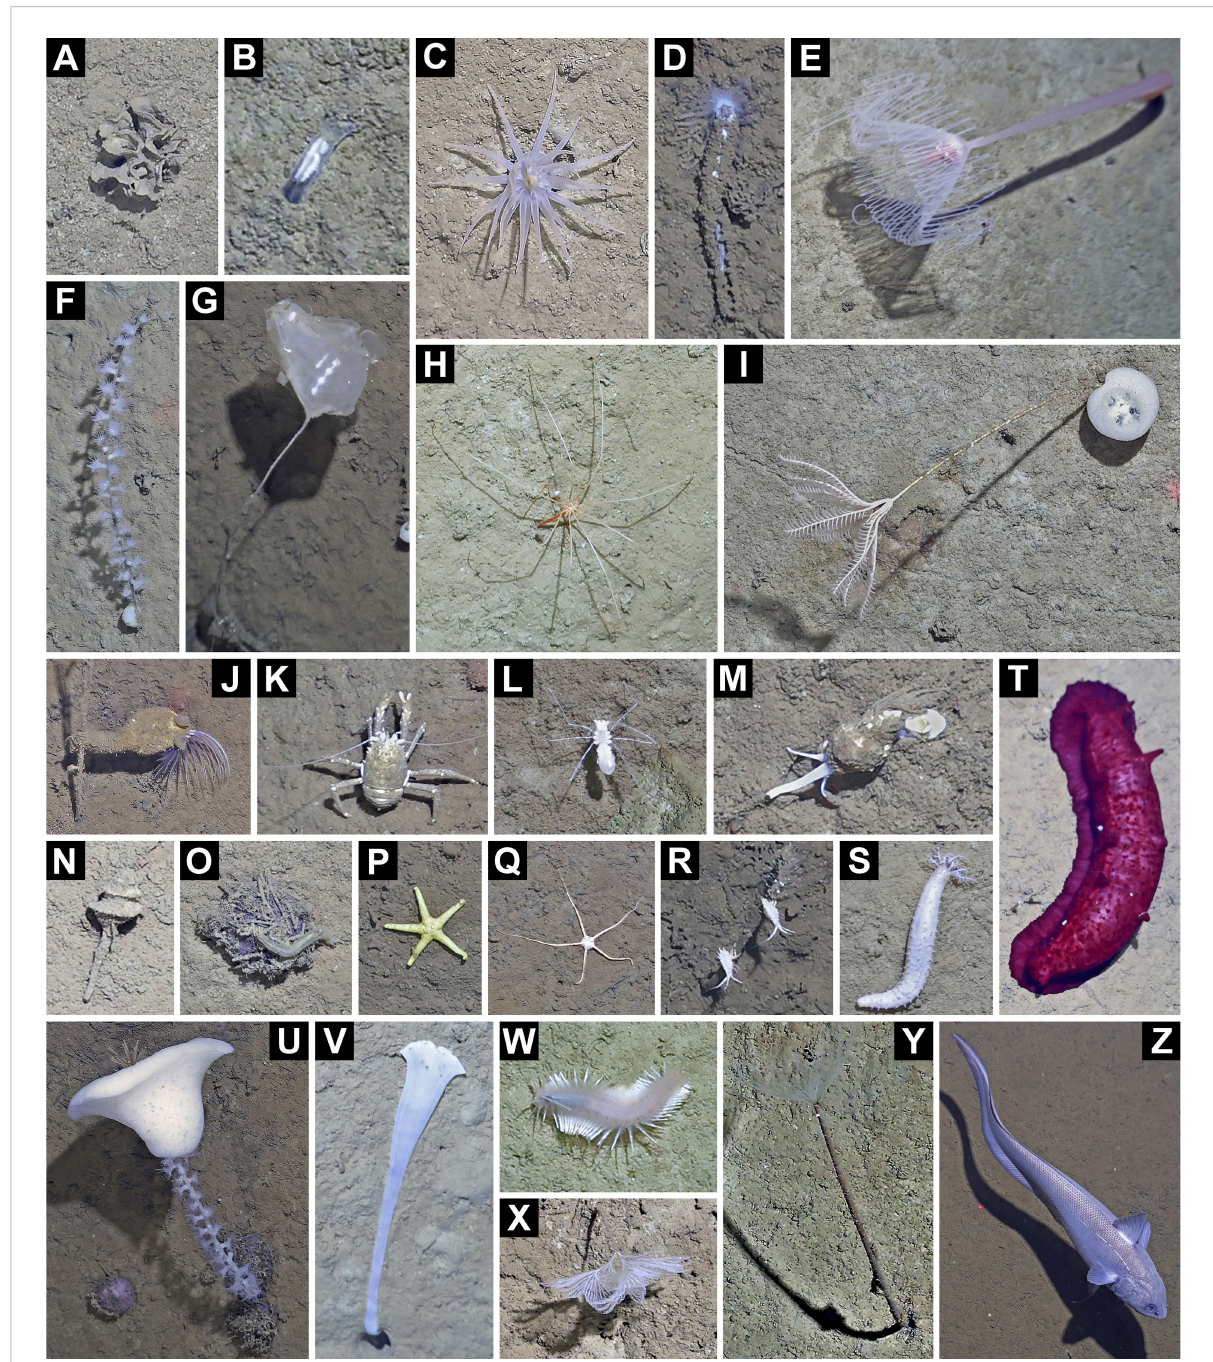
FIGURE 3 Representative megafauna sighted in the Aleutian Basin, Bering Sea. (A) Convoluted xenophyophore, (B) Enteropneusta indet., (C, D) tube anemone (Actiniaria indet.), (E) the giant solitary hydroid Branchiocerianthus imperator , (F) the zoantharian Macrocnemina sp. 2, (G) benthic Ctenophora indet., (H) the pycnogonid Colossendeidae indet., (I) the stalked crinoid Bathycrinus sp., (J) the stalked barnacle cf. Trianguloscalpellum sp., (K) Munidopsis sp. squat lobster, (L) the munnopsid isopod Munneurycope sp., (M) the buccinid snail cf. Ancistrolepis sp., (N) the pagoda snail Tropidofusus aequilanius , (O) the irregular urchin Cystechinus loveni adorned with Foraminifera tests (a behaviour previously reported in Levin et al., 2001b) and a Dendrochirotida indet. holothurian, (P) the asteroid Henricia sp., (Q) the brittle star Ophiura sp., (R) the amathillopsid amphipod Amathillopsis sp. clinging to a ‘ stick ’ (as previously reported in Lörz and Horton, 2021), (S) the holothurian Abyssocucumis sp., (T) the namako Benthodytes cf. marianensis , (U) the hexactinellid sponge cf. Caulophacus sp., (V) extended proboscis of Echiura indet., (W) the scale worm Polynoida indet., (X) the sabellid worm morphotype with bilobed crown, (Y) the sabellid worm morphotype with single-lobed crown, (Z) the Giant Grenadier Albatrossia pectoralis